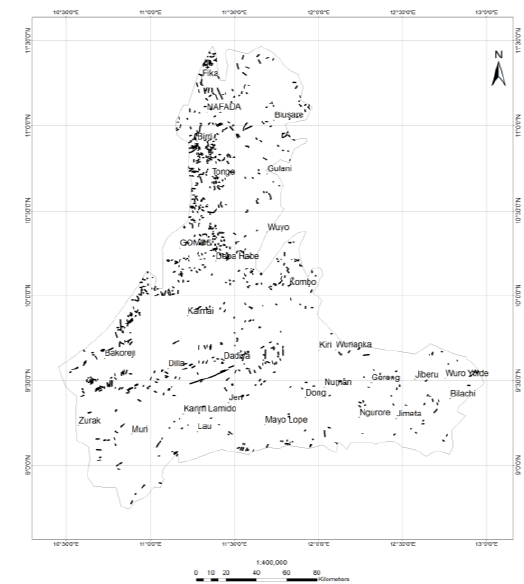
Figure 13 . Lineaments extracted within the Upper Benue Trough